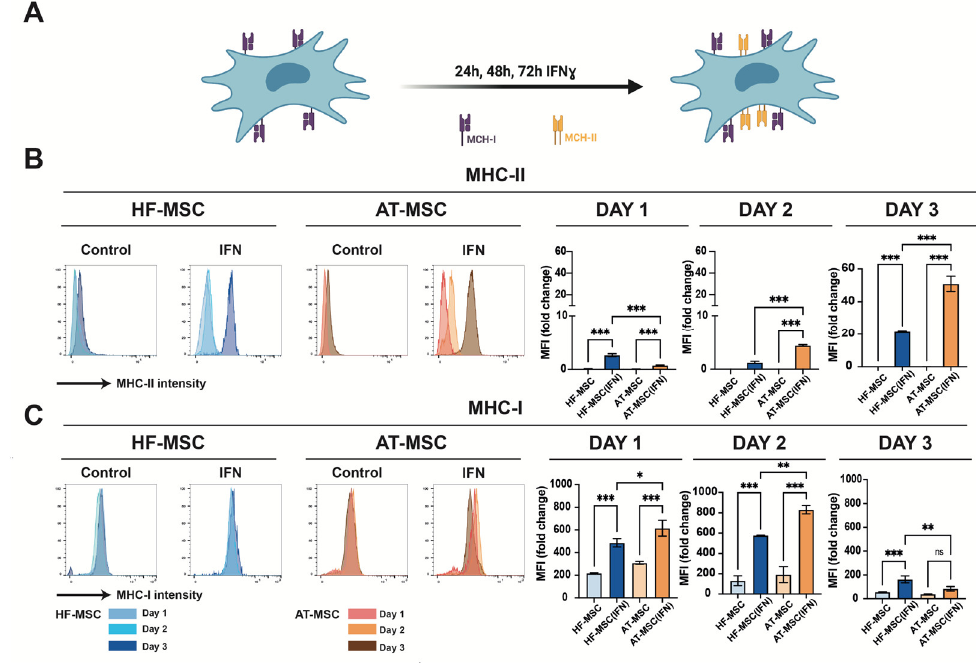
Figure 4. Effect of IFN γ on HF-MSCs immunoevasiveness. ( A ) IFN γ upregulates the MHC-II expression in MSCs. ( B , C ) Histograms from flow cytometry assays depicting percentage of HF-MSCs positively stained for MHC-II ( B ) and MHC-I ( C ) on unstimulated and IFN γ -licensed HF-MSCs and AT-MSCs over 1, 2, or 3 days. Each datapoint represents the mean for at least three biological replicates ± SD. Statistical significance: *** p < 0.001 ** p < 0.01, * p < 0.05, ns, no significant difference p > 0.05. IFNγ, interferon gamma. MHC-I, major histocompatibility class I molecule. MHC-II, major histocompatibility class II molecule. HF-MSCs, hair follicle-derived MSCs. AT-MSC, adipose tissue-derived MSCs.